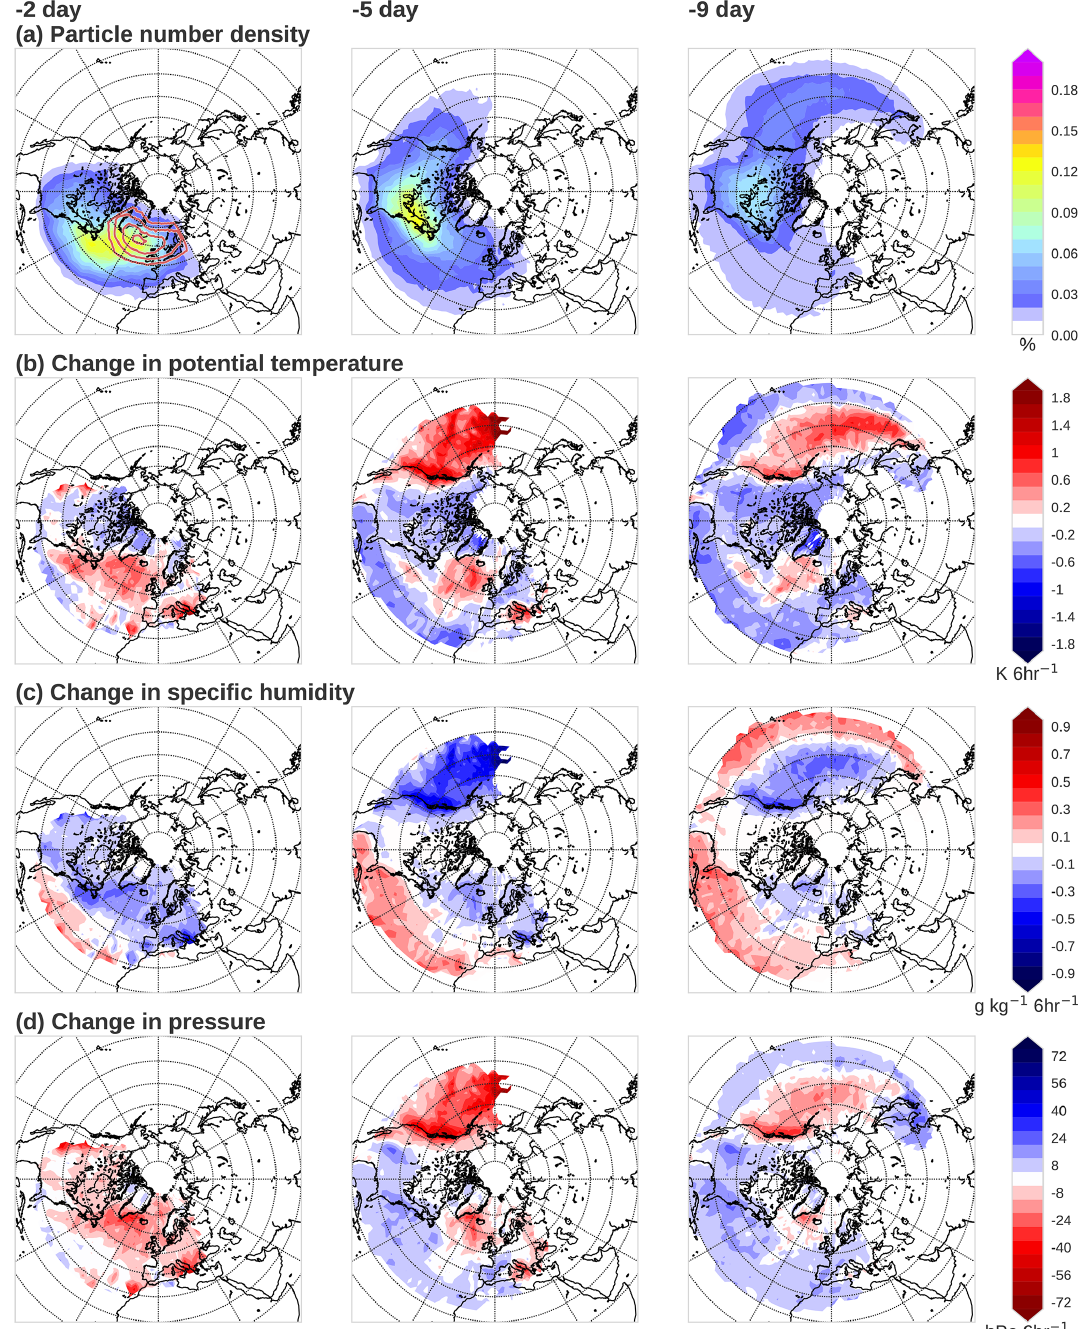
Figure 4. Same as Fig. 3 but for moist particles above the marine PBL or within or above the PBL over land. By definition they are not under the influence of the turbulent heat fluxes from the